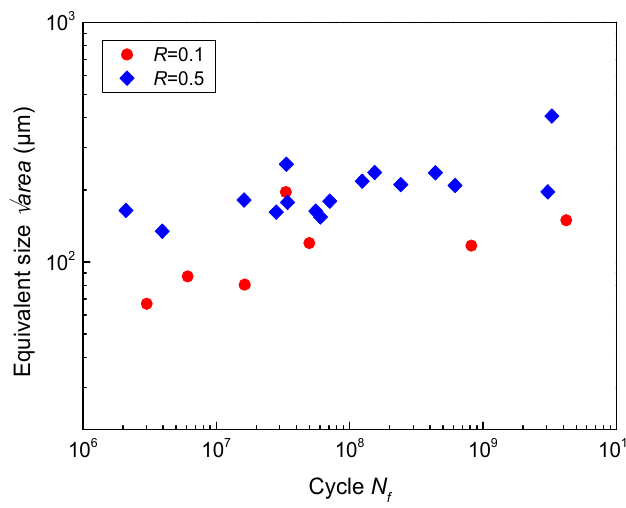
Figure 7. The equivalent size of the single-point surface crack initiation region versus fatigue life for notched specimens.